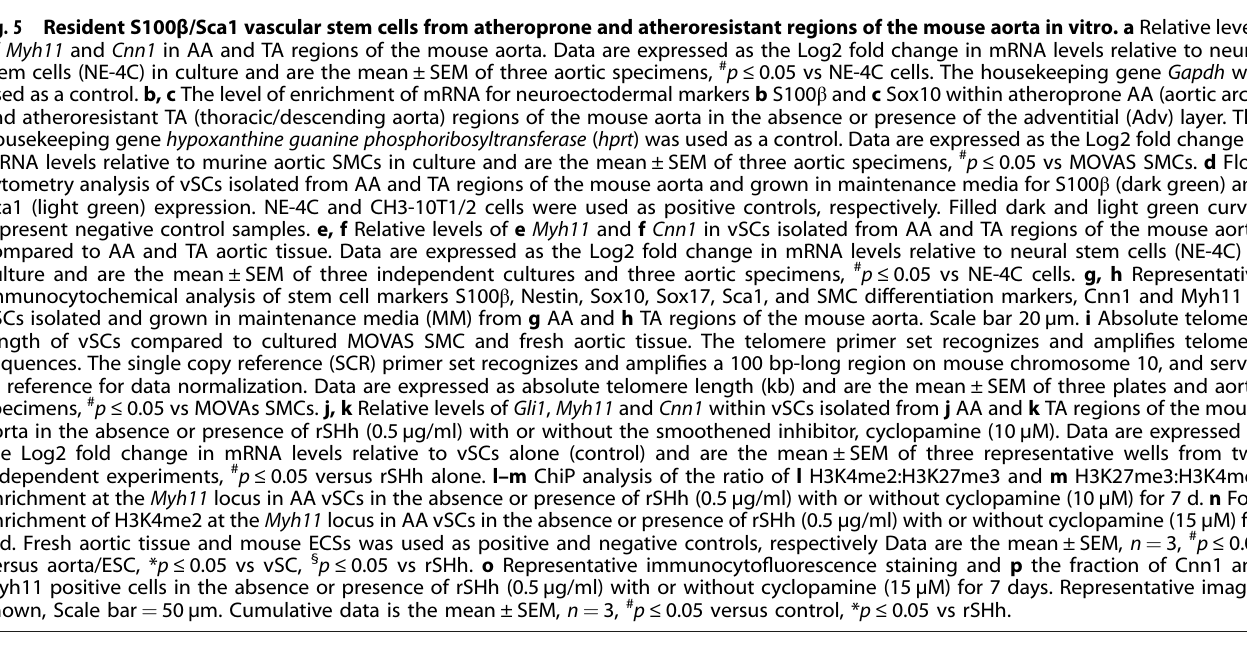
Fig. 5 Resident S100 β /Sca1 vascular stem cells from atheroprone and atheroresistant regions of the mouse aorta in vitro. a Relative levels of Myh11 and Cnn1 in AA and TA regions of the mouse aorta. Data are expressed as the Log2 fold change in mRNA levels relative to neural stem cells (NE-4C) in culture and are the mean ± SEM of three aortic specimens, # p ≤ 0.05 vs NE-4C cells. The housekeeping gene Gapdh was used as a control. b, c The level of enrichment of mRNA for neuroectodermal markers b S100 β and c Sox10 within atheroprone AA (aortic arch) and atheroresistant TA (thoracic/descending aorta) regions of the mouse aorta in the absence or presence of the adventitial (Adv) layer. The housekeeping gene hypoxanthine guanine phosphoribosyltransferase ( hprt ) was used as a control. Data are expressed as the Log2 fold change in mRNA levels relative to murine aortic SMCs in culture and are the mean ± SEM of three aortic specimens, # p ≤ 0.05 vs MOVAS SMCs. d Flow cytometry analysis of vSCs isolated from AA and TA regions of the mouse aorta and grown in maintenance media for S100 β (dark green) and Sca1 (light green) expression. NE-4C and CH3-10T1/2 cells were used as positive controls, respectively. Filled dark and light green curves represent negative control samples. e, f Relative levels of e Myh11 and f Cnn1 in vSCs isolated from AA and TA regions of the mouse aorta, compared to AA and TA aortic tissue. Data are expressed as the Log2 fold change in mRNA levels relative to neural stem cells (NE-4C) in culture and are the mean ± SEM of three independent cultures and three aortic specimens, # p ≤ 0.05 vs NE-4C cells. g, h Representative immunocytochemical analysis of stem cell markers S100 β , Nestin, Sox10, Sox17, Sca1, and SMC differentiation markers, Cnn1 and Myh11 in vSCs isolated and grown in maintenance media (MM) from g AA and h TA regions of the mouse aorta. Scale bar 20 µm. i Absolute telomere length of vSCs compared to cultured MOVAS SMC and fresh aortic tissue. The telomere primer set recognizes and ampli fi es telomere sequences. The single copy reference (SCR) primer set recognizes and ampli fi es a 100 bp-long region on mouse chromosome 10, and serves as reference for data normalization. Data are expressed as absolute telomere length (kb) and are the mean ± SEM of three plates and aortic specimens, # p ≤ 0.05 vs MOVAs SMCs. j, k Relative levels of Gli1 , Myh11 and Cnn1 within vSCs isolated from j AA and k TA regions of the mouse aorta in the absence or presence of rSHh (0.5 µg/ml) with or without the smoothened inhibitor, cyclopamine (10 µM). Data are expressed as the Log2 fold change in mRNA levels relative to vSCs alone (control) and are the mean ± SEM of three representative wells from two independent experiments, # p ≤ 0.05 versus rSHh alone. l – m ChiP analysis of the ratio of l H3K4me2:H3K27me3 and m H3K27me3:H3K4me2 enrichment at the Myh11 locus in AA vSCs in the absence or presence of rSHh (0.5 µg/ml) with or without cyclopamine (10 µM) for 7 d. n Fold enrichment of H3K4me2 at the Myh11 locus in AA vSCs in the absence or presence of rSHh (0.5 µg/ml) with or without cyclopamine (15 µM) for 7 d. Fresh aortic tissue and mouse ECSs was used as positive and negative controls, respectively Data are the mean ± SEM, n = 3, # p ≤ 0.05 versus aorta/ESC, * p ≤ 0.05 vs vSC, § p ≤ 0.05 vs rSHh. o Representative immunocyto fl uorescence staining and p the fraction of Cnn1 and Myh11 positive cells in the absence or presence of rSHh (0.5 µg/ml) with or without cyclopamine (15 µM) for 7 days. Representative images shown, Scale bar = 50 µm. Cumulative data is the mean ± SEM, n = 3, # p ≤ 0.05 versus control, * p ≤ 0.05 vs